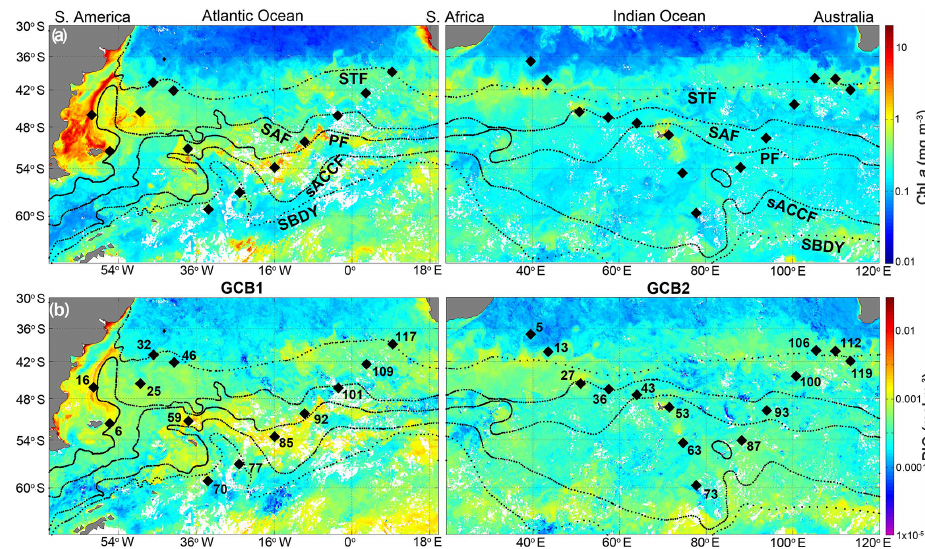
Figure 1. Rolling 32-day composite from MODIS Aqua for both (a) chlorophyll a (mgm − 3 ) and (b) PIC (molm − 3 ) for the South Atlantic sector (17 January to 17 February 2011) and the South Indian sector (18 February to 20 March 2012). Station number identifiers and averaged positions of fronts as defined by Orsi et al. (1995) are superimposed: Subtropical Front (STF), Subantarctic Front (SAF), Polar Front (PF), Southern Antarctic Circumpolar Current Front (SACCF), and southern boundary